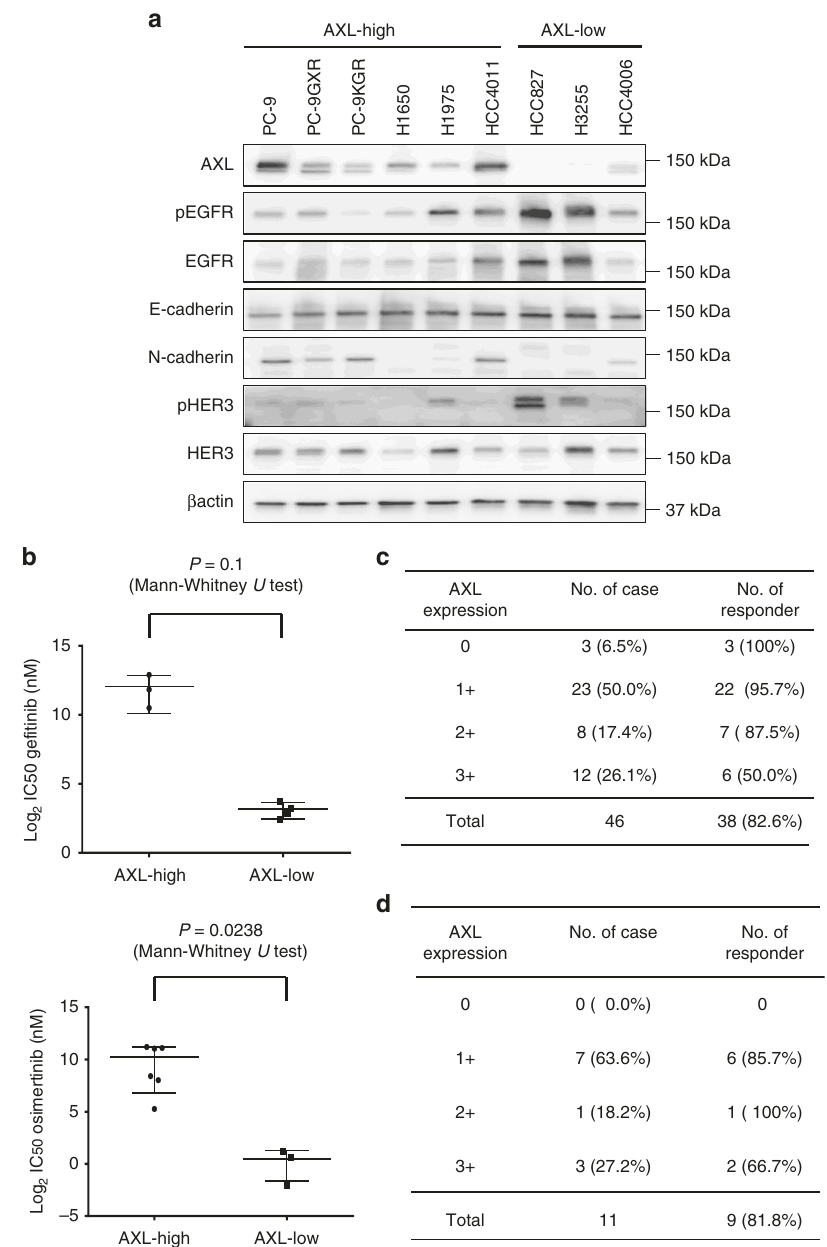
Fig. 2 AXL protein expression inversely correlated with susceptibility to EGFR-TKIs. a The EGFR -mutated NSCLC cell lines PC-9, PC-9GXR, PC-9KGR, H1650, H1975, HCC4011, HCC827, H3255, and HCC4006 were lysed and the indicated proteins were detected by western blotting. b The IC50 values for the EGFR-TKIs ge fi tinib and osimertinib in EGFR -mutated NSCLC cells. The IC50 values for both ge fi tinib and osimertinib were signi fi cantly higher in cells expressing high levels of AXL compared to cells expressing low levels of AXL. P values were calculated using the Mann Whitney U test. c Correlation between the cytoplasmic AXL protein expression levels determined immunohistochemically and the response to treatment with EGFR-TKIs in EGFR - mutated NSCLC specimens from 46 patients. d Correlation between the expression levels of the cytoplasmic AXL protein, determined immunohistochemically, and response to treatment with osimertinib in EGFR -mutated NSCLC specimens from 11 osimertinib alone (Supplementary Figure 10). Combined use of another AXL inhibitor (ASP2215) with osimertinib for 72 h also produced similar effects in PC-9 and HCC4011 cells (Supple- mentary Figure 11) compared with the treatment of the cells with osimertinib alone. Figure 12). The expression of stem cell- and EMT-related proteins was not remarkably affected by osimertinib with or without NPS1034 (Supplementary Figure 13). These results clearly indicated that the cell sensitivity to osimertinib could be increased by the combined treatment with